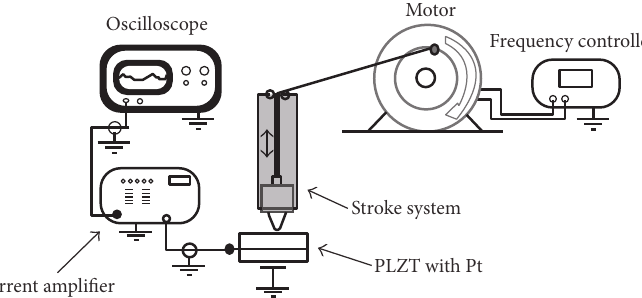
Figure 2: System to determine mechanical characterization on PLZT ceramic with Pt.